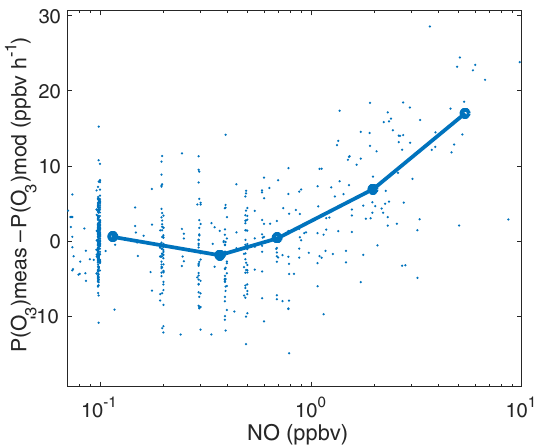
Figure 4. Difference between measured and modeled P(O 3 ) as a function of measured NO. Individual points are averaged for 30min, while the solid line indicates the average P(O 3 ) difference binned by